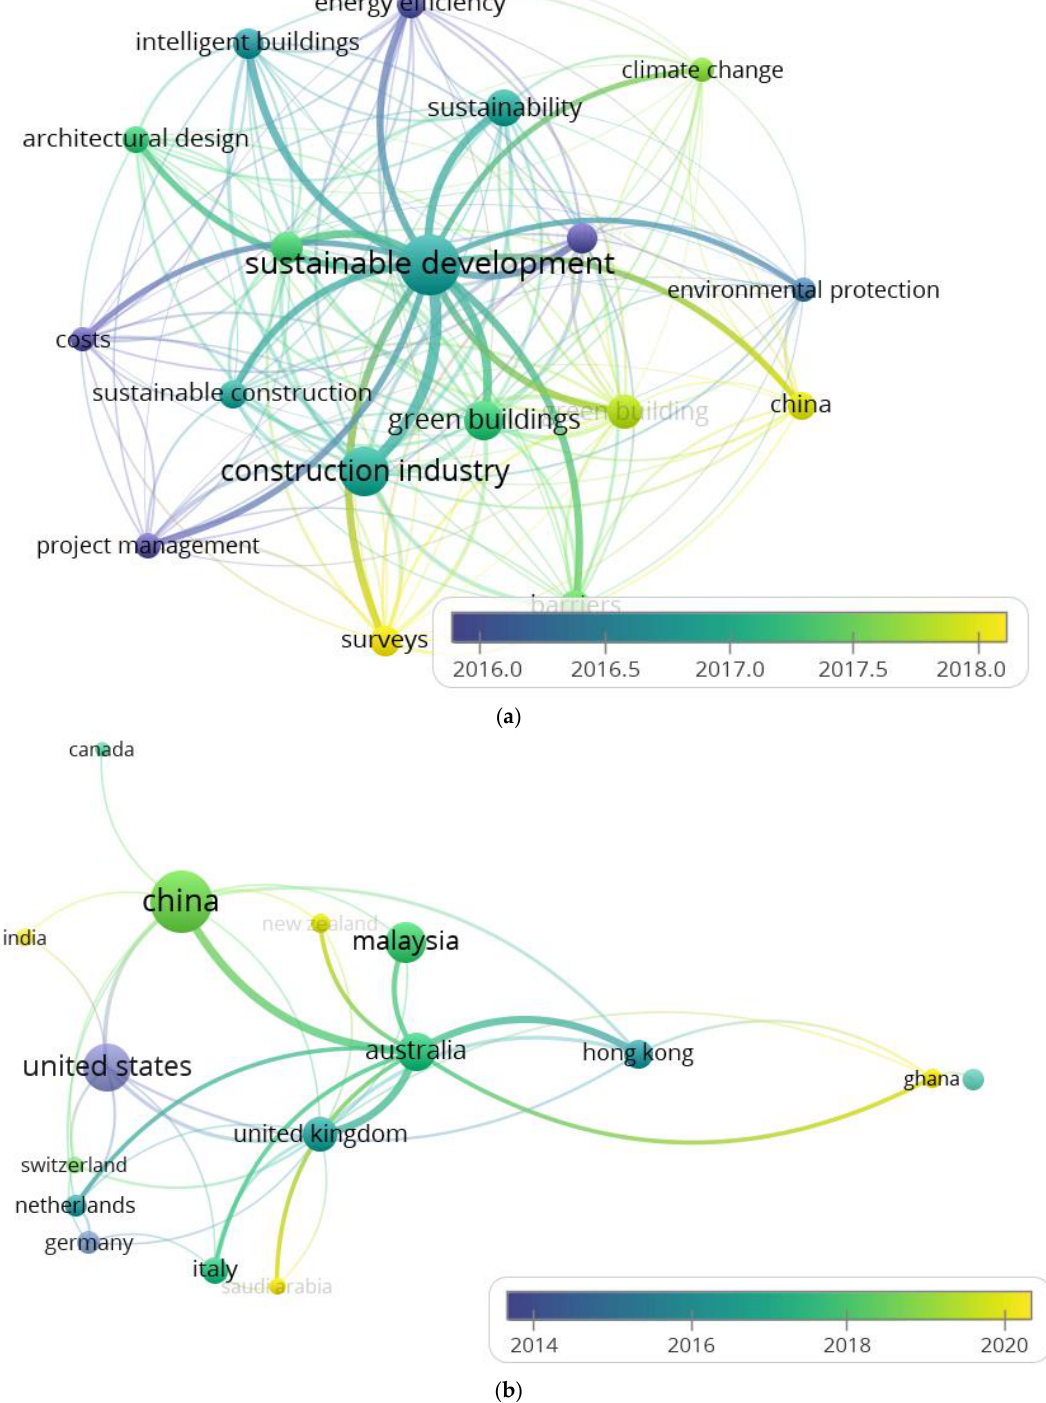
Figure 2. The outputs of network analysis by ( a ) keyword repetition and ( b ) countries’ contributions.